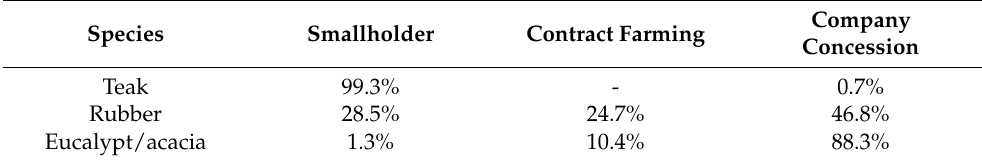
Table 1. Proportion of plantation area by ownership in Laos